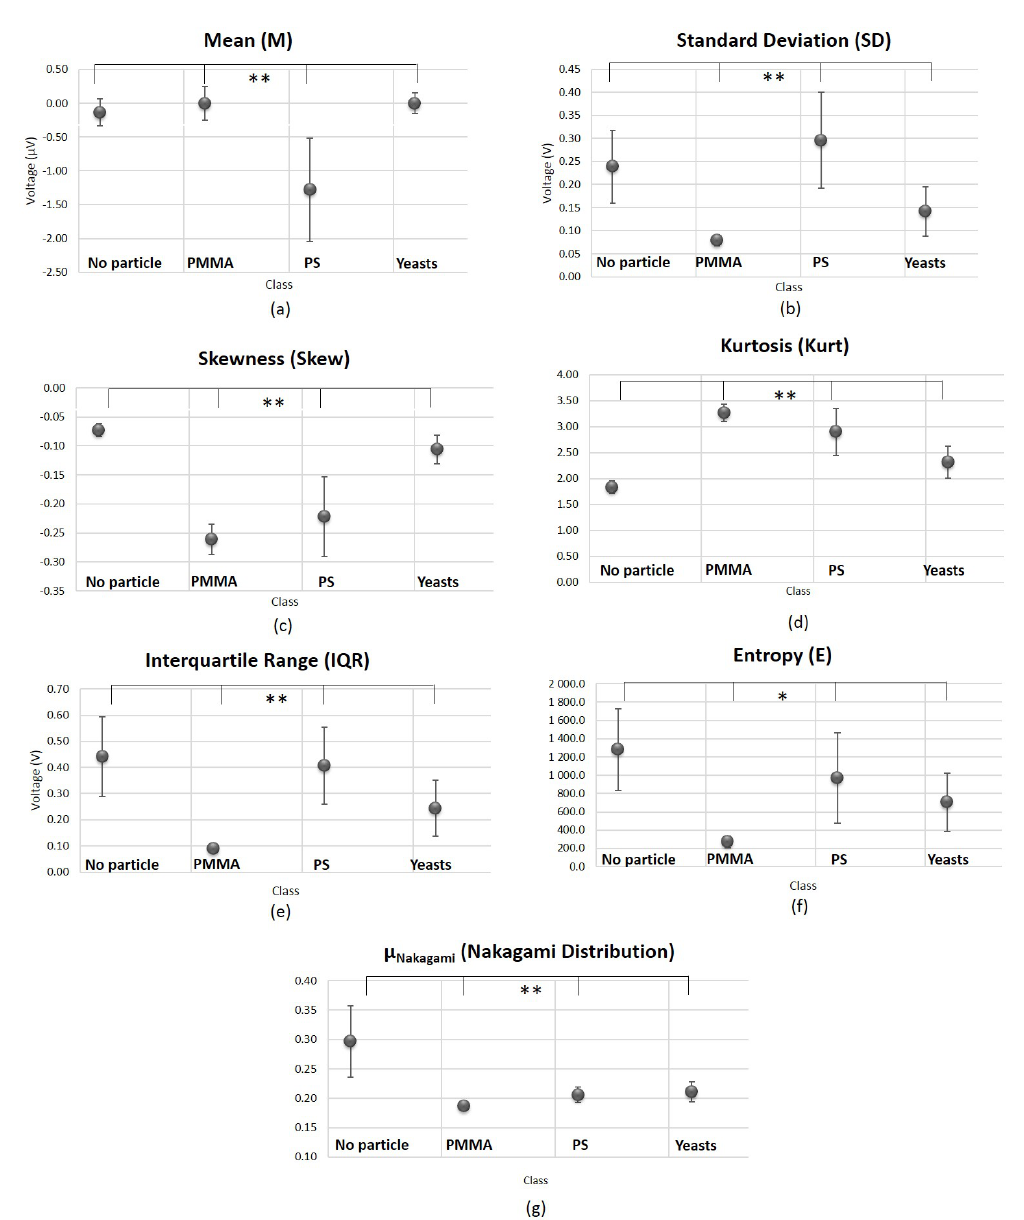
Figure 9. Graphical representation of the statistical comparisons relative to the back-scattered signal time-domain features analyzed (4 classes comparisons, Kruskal-Wallis test). ( a – f ) Comparisons made regarding time-domain statistics features. ( g ) Results obtained for µ Nakagami . The error bars represent standard error values. ** p < 0.001. * p < 0.05. N No particle = 16; N PMMA = 16; N PS = 18; N Yeasts =